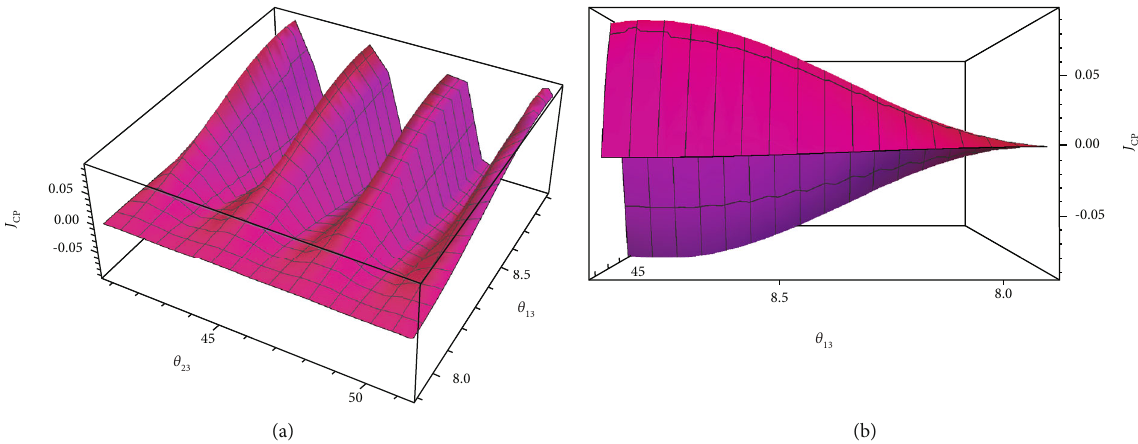
Figure 9: Predictions in the broken μ − τ symmetry model for normal ordering: (b) preferred three-dimensional regions of the ( θ plane for the best fi t values of δ = 222 ° of Δχ 2 = 6 : 2 w/o SK-ATM [14]; (a) allowed two-dimensional space of the ( θ CP fi t values of δ = 222 ° of Δχ 2 = 6 : 2 w/o SK-ATM [14]. CP